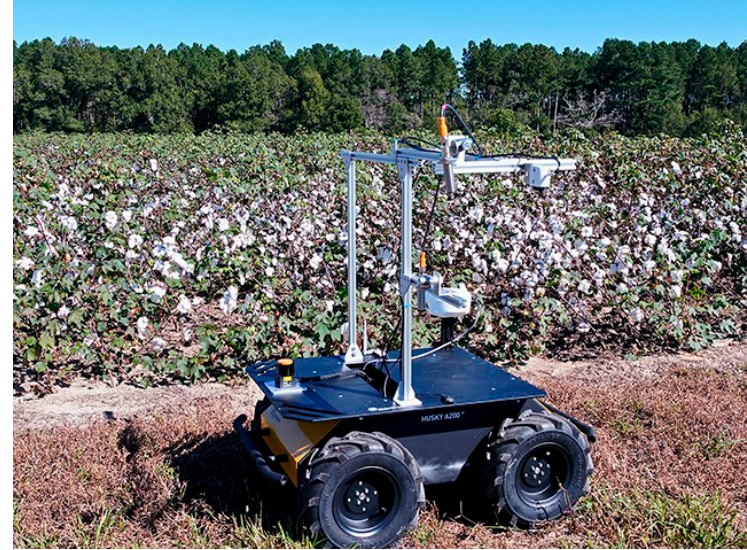
Figure 8. Cotton picking robot prototype proposed by Clemson University (source: www.agweb.com).